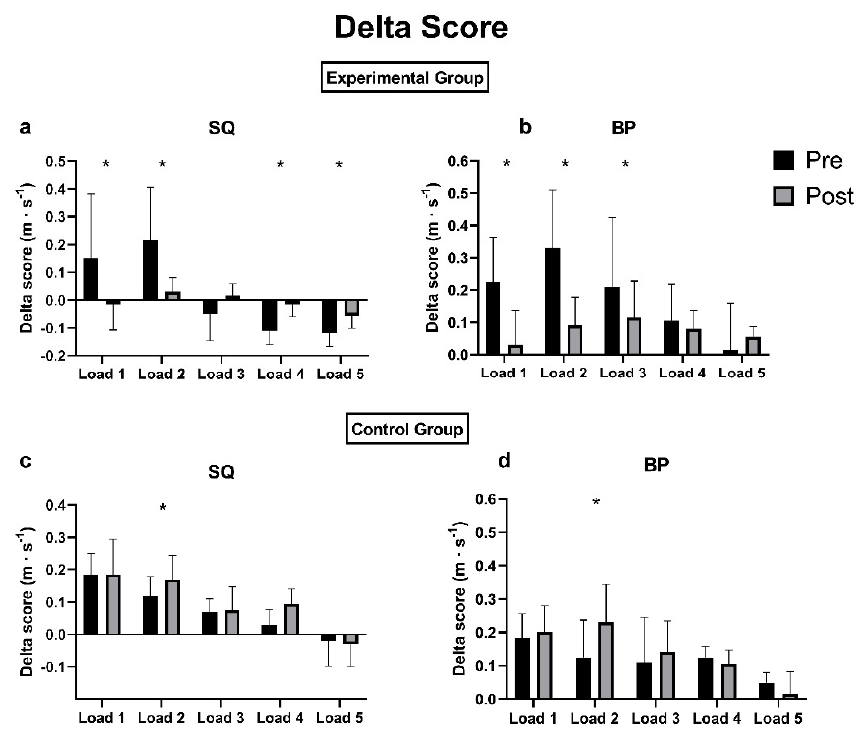
Figure 2. Delta score for each load from the lightest (load 1) to the heaviest (load 5).